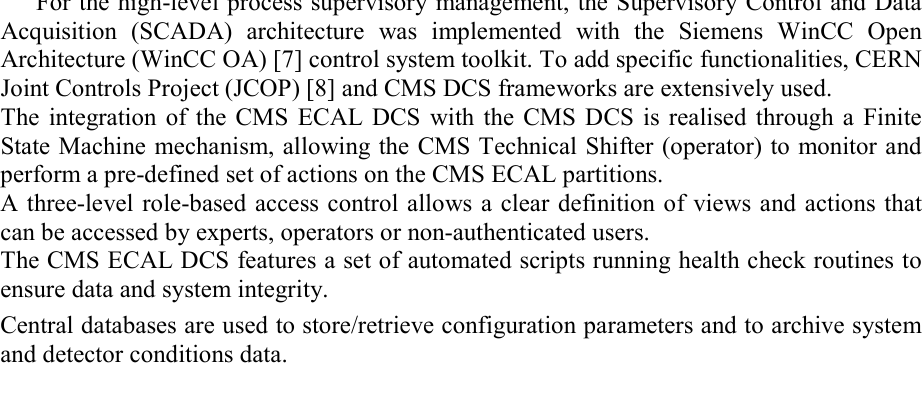
Figure 2. The CMS ECAL DCS architecture.